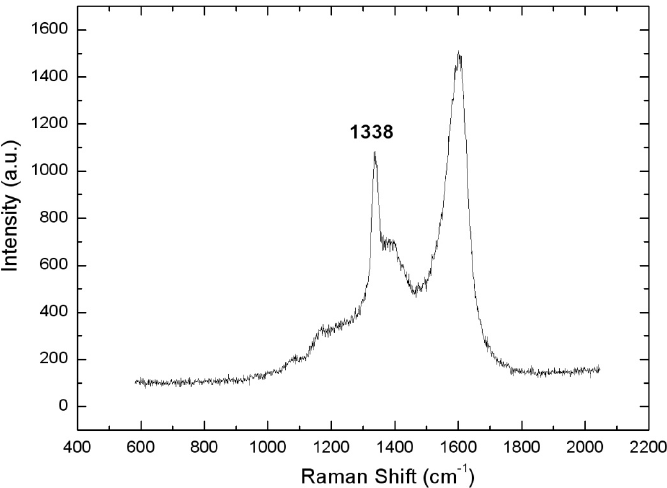
Figure 12. Raman spectrum (excitation with laser at 325 nm) of NCD diamond deposited at 550 °C on AISI 304 stainless ‐ steel with laser cladding with a single layer SiC [28]. Reused with permission. Copyright 2016